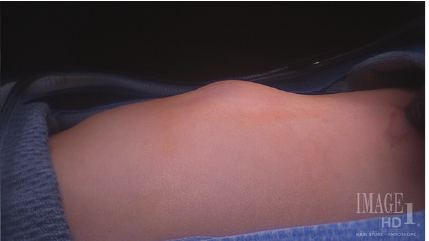
Figure 1: View of the lateral chest wall demonstrates a protrusion in the region of the left lateral 7th rib. The patient is lying in the right lateral recumbent position.